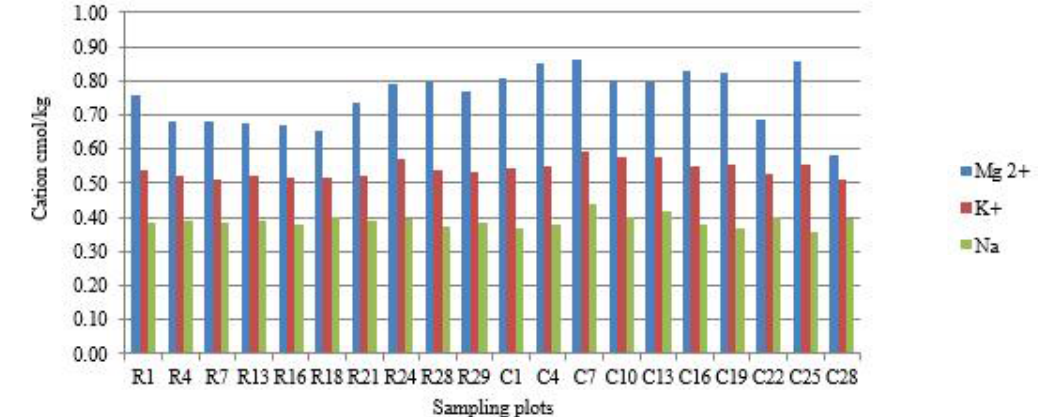
Fig. 7: Variation in cations exchange capacity for soils from the road verge and the core area habitat